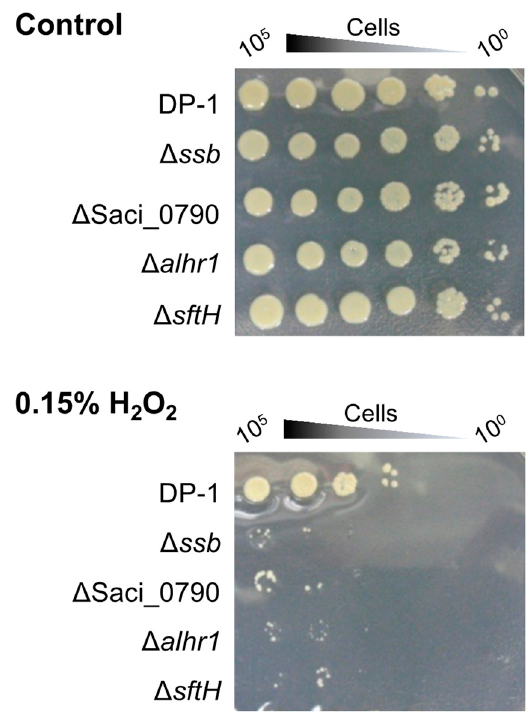
Figure 6. Hydrogen peroxide survival of gene-deleted strains. After each of the cultures was treated with hydrogen peroxide (0.15%) followed by the preparation of diluted samples (10 − 1 –10 − 5 corresponding to 10 5 –10 0 cells), the samples were spotted on plates and cultivated at 75 ◦ C. Controls indicate mock-treated samples. Experiments were repeated three times with similar results.